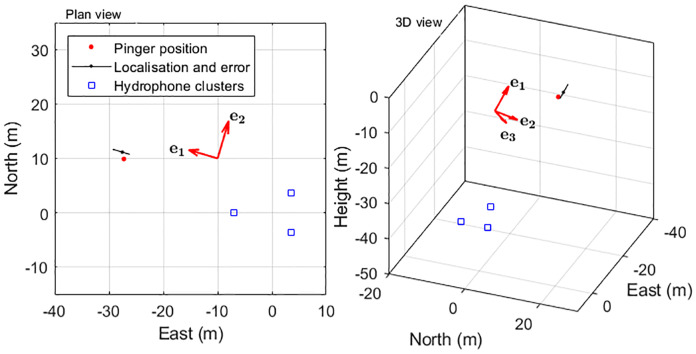
Localisation error coordinate frame.The figure shows the localisation and error estimate of a single click from the pinger trial (see below) which was detected on the north and the west hydrophone cluster, but not the south one. The largest error is in the estimation of range e1, so this is aligned with a unit vector from the centre of the array. The other (smaller) errors e2 and e3 are aligned with the horizontal and vertical angle measurements.